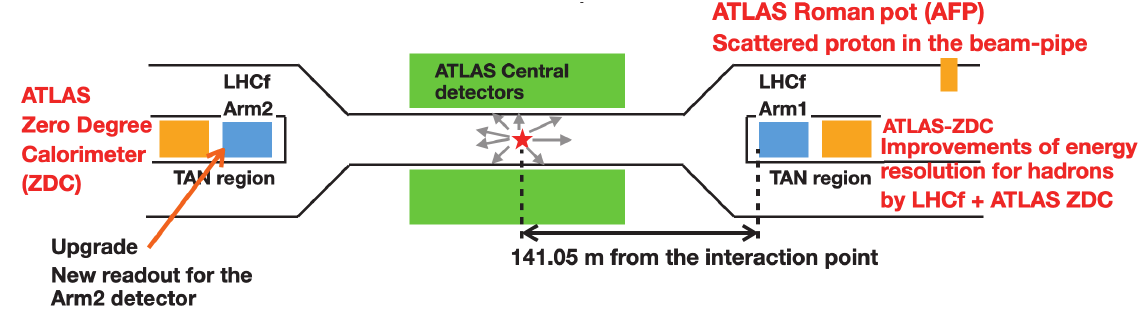
Figure 2. A schematic view of detector configurations of the data-taking in Sept.